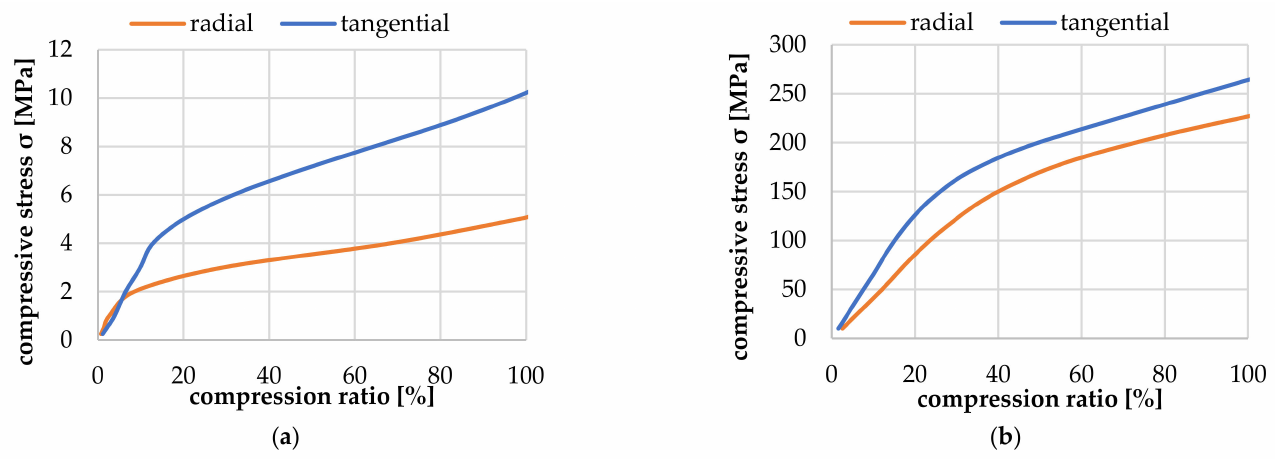
Figure 9. Simulation result for the compression behavior of an EW ( a ) and LW tracheid ( b ) at 23 ◦ C and 12% moisture